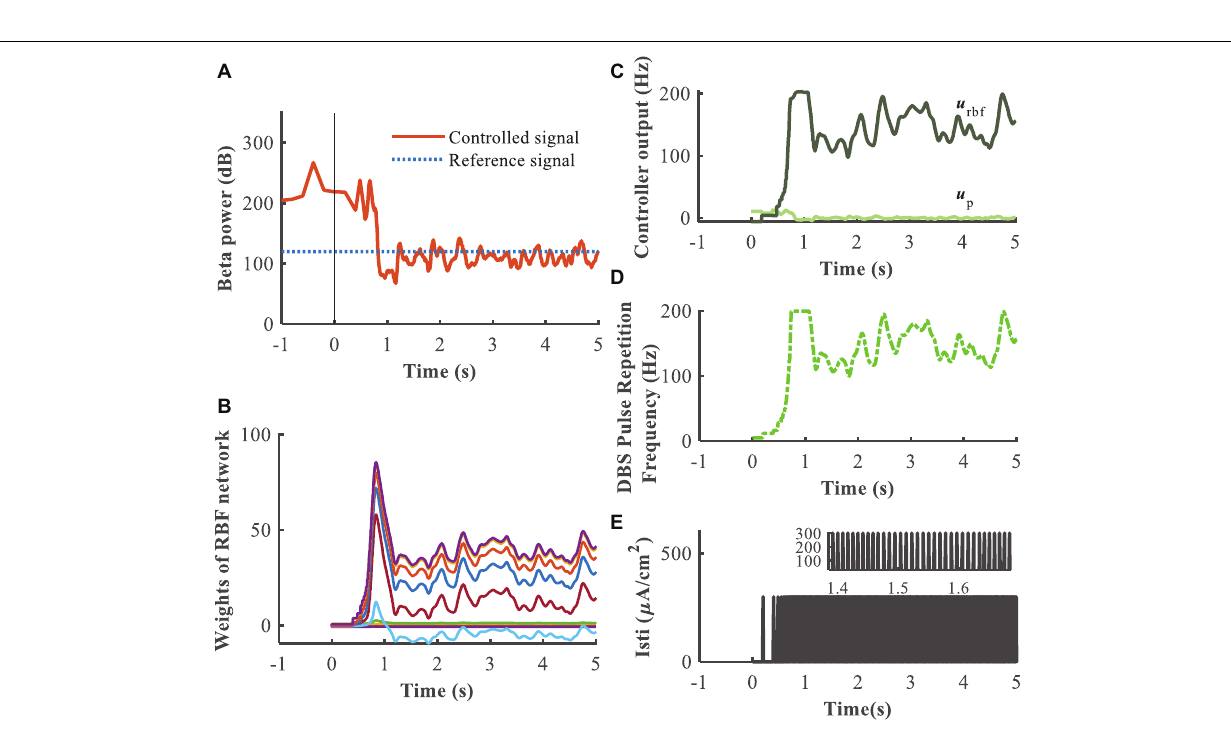
Frontiers in Neuroscience |